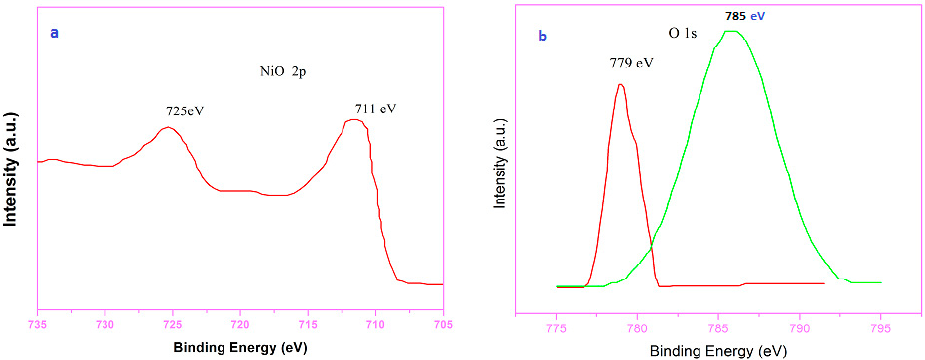
Figure 6. X-ray Photoelectron Spectroscopy (XPS) spectra of ( a ) Ni 2p; and ( b ) O 1s.